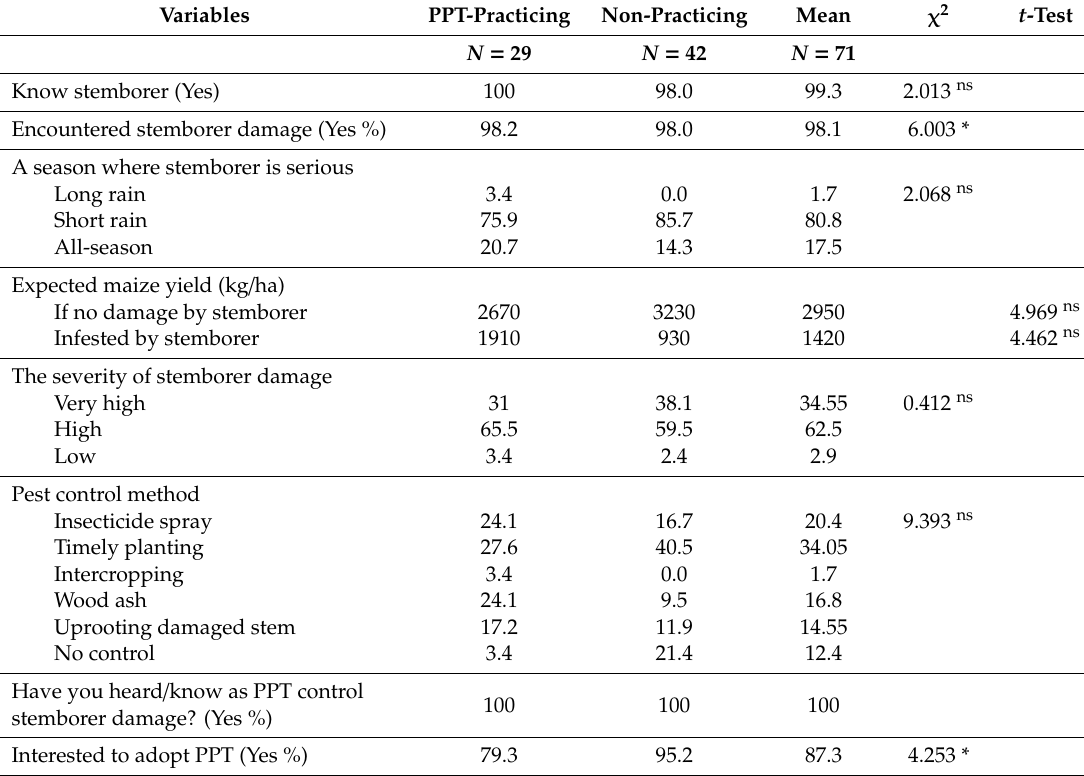
Table 3. Farmers’ knowledge and perceptions of stemborer in the Hawassa district,